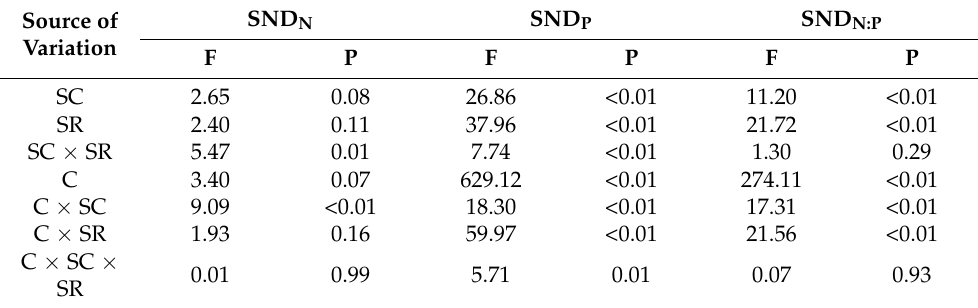
Table 7. Three-way ANOVAs on effects of species combination (SC), sowing ratio (SR), and cut (C) on soil N density (SND N ), soil P density (SND P ), and their stoichiometric ratio (SND N:P ). Source